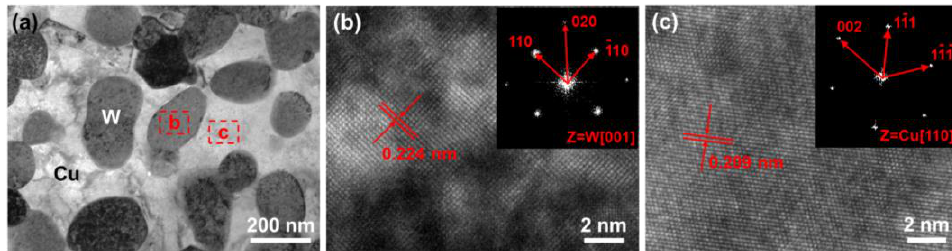
Figure 2. TEM bright field image ( a ) and high-resolution TEM images ( b , c ) of the UFG W – Cu composite, inserts in ( b , c ) are the corresponding fast Fourier transformation patterns. Table 1. Properties of the CCG W – Cu and UFG W – Cu composites.